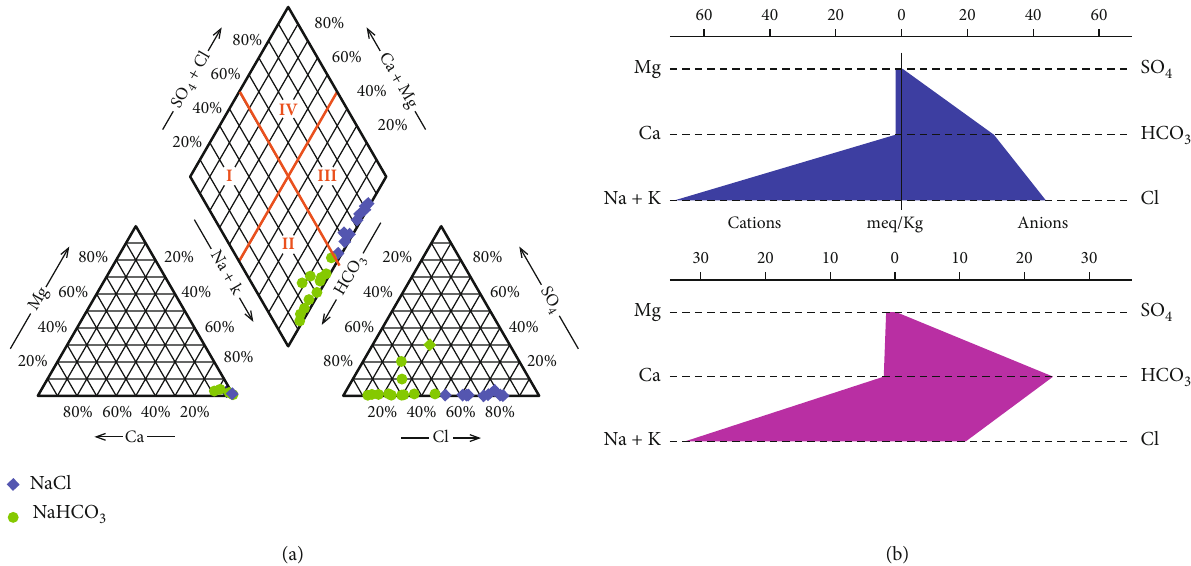
Figure 5: Water chemical characteristics of coal reservoir in Anze Block. (a) Piper trilinear diagram of water chemistry. (b) Sti ff water pattern diagram of